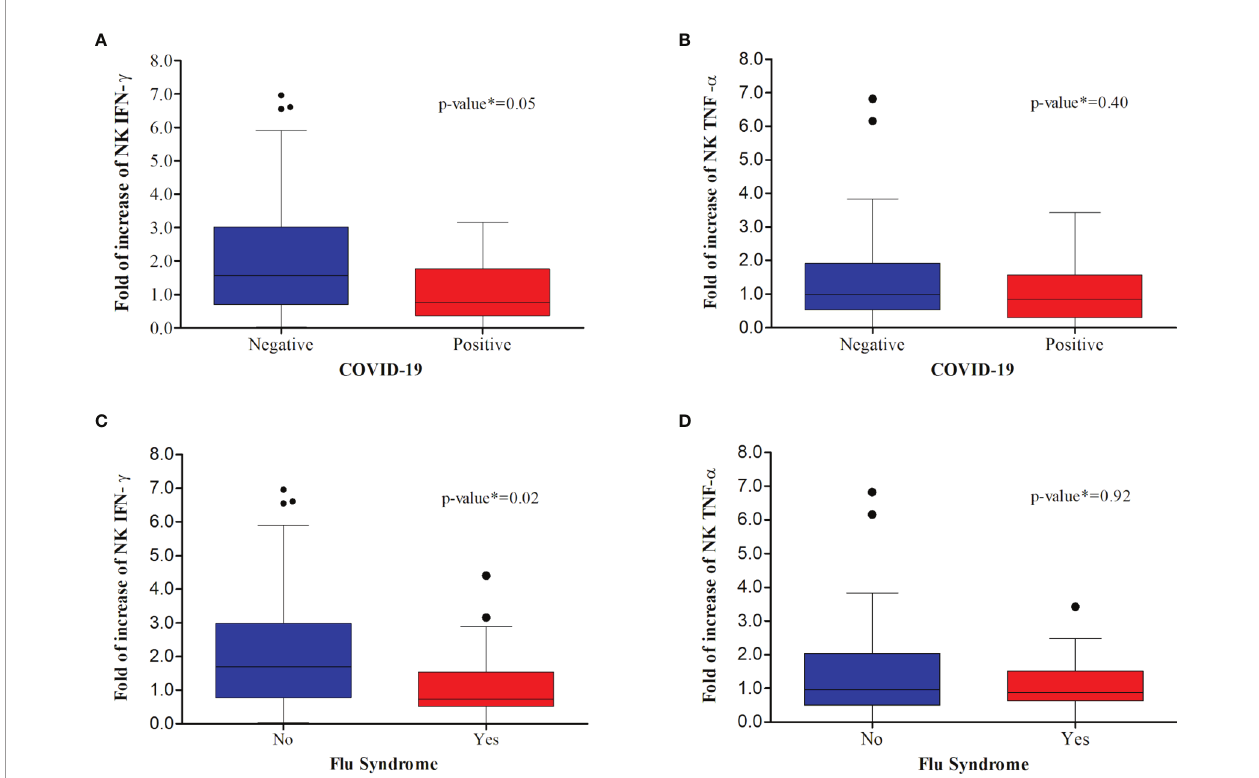
FIGURE 3 | Comparative analysis between con fi rmed COVID-19 and immunological markers: (A, C) fold increase of day 15 relative to day one of NK cells positive for IFN- g ; (B, D) fold increase of day 15 relative to day one of NK cells positive for TNF- a . Among individuals that acquired COVID-19 (A, B) , there was a signi fi cant decrease in the fold increase of NK IFN- g cells. Similarly, there was a signi fi cant decrease in the fold increase of NK IFN- g cells between those individuals that presented fl u syndrome (C, D)